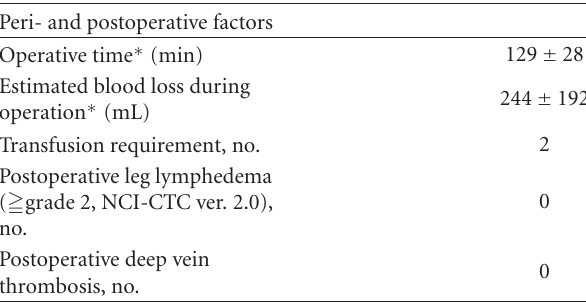
Table 3: Peri- and postoperative morbidities and complications. Peri- and postoperative